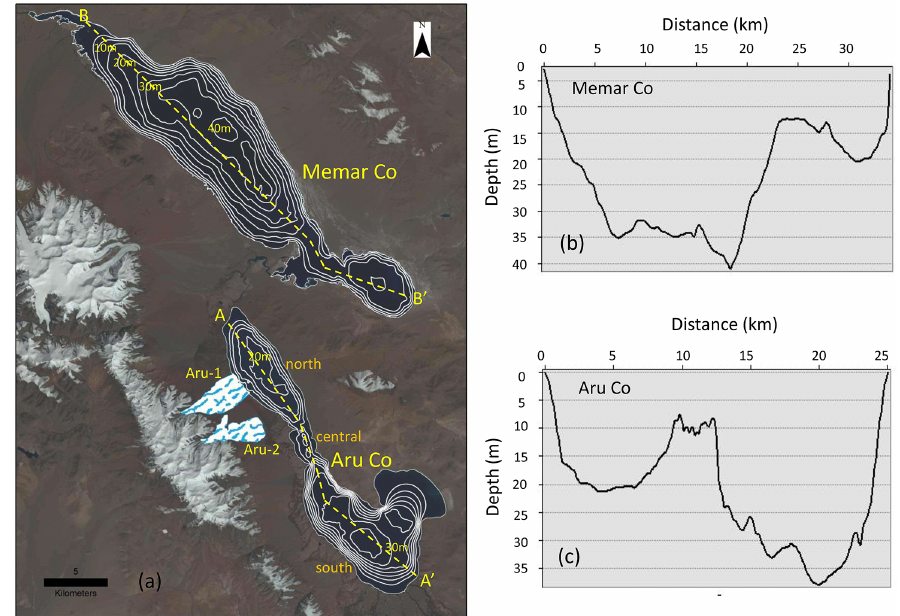
Figure 2. The 5m interval isobaths (a) and the water depth profiles (b, c) in a NW–SE direction (the dashed yellow lines) at Aru Co and Memar Co. Landsat satellite image (a) is used to indicate the location of the lakes and glacier